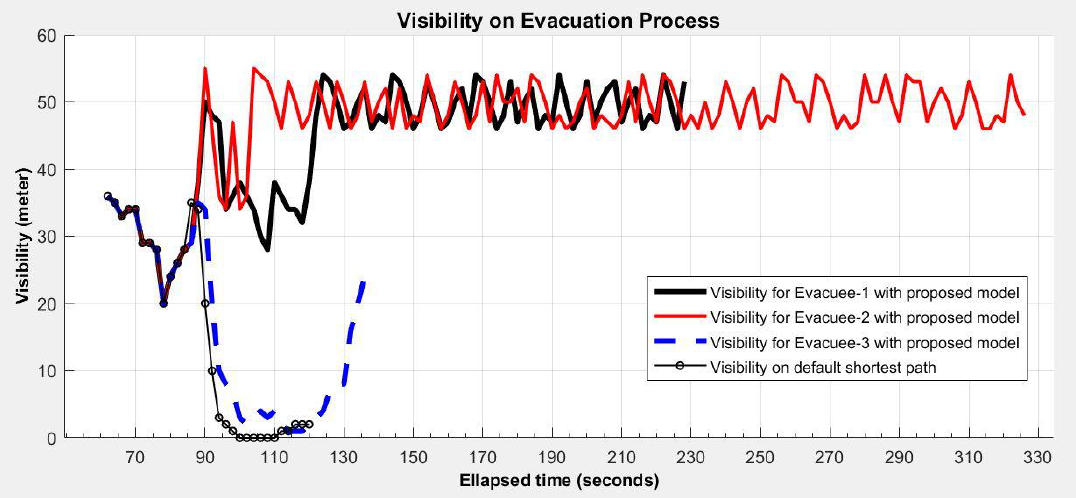
Figure 12. Visibility–time chart. Table 7. Evacuation summary for all